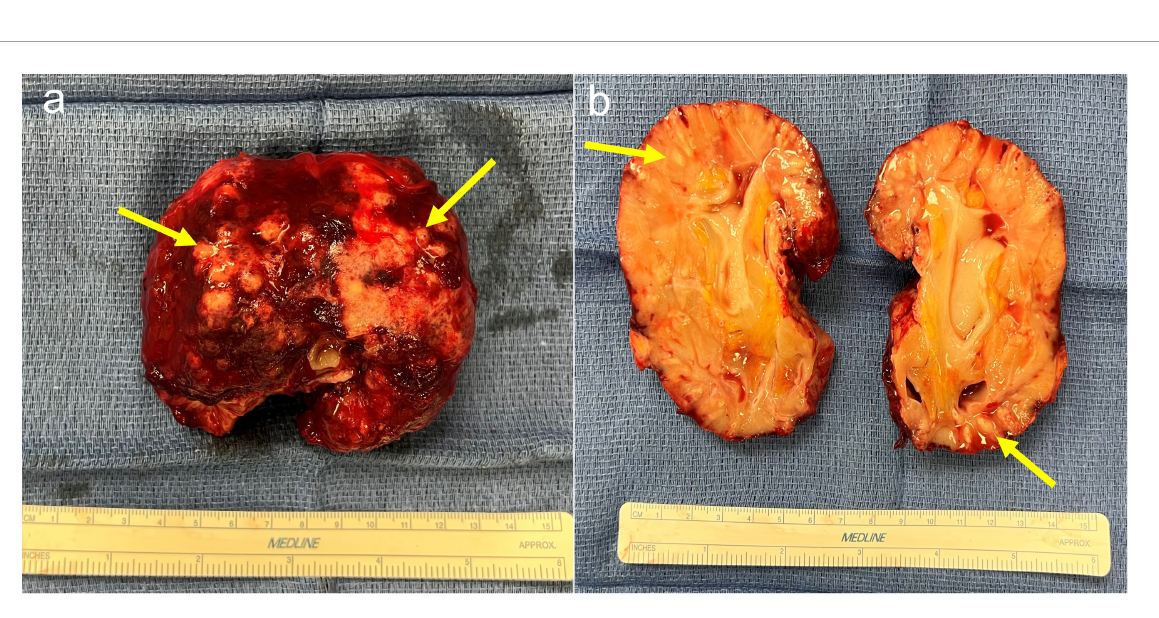
FIGURE3 (a) Explant of kidney allograft demonstrating multiple abscesses with fibrinous exudate and thick rind material. (b) Bisected kidney allograft demonstrating diffusely pale parenchyma and multifocal areas of purulent